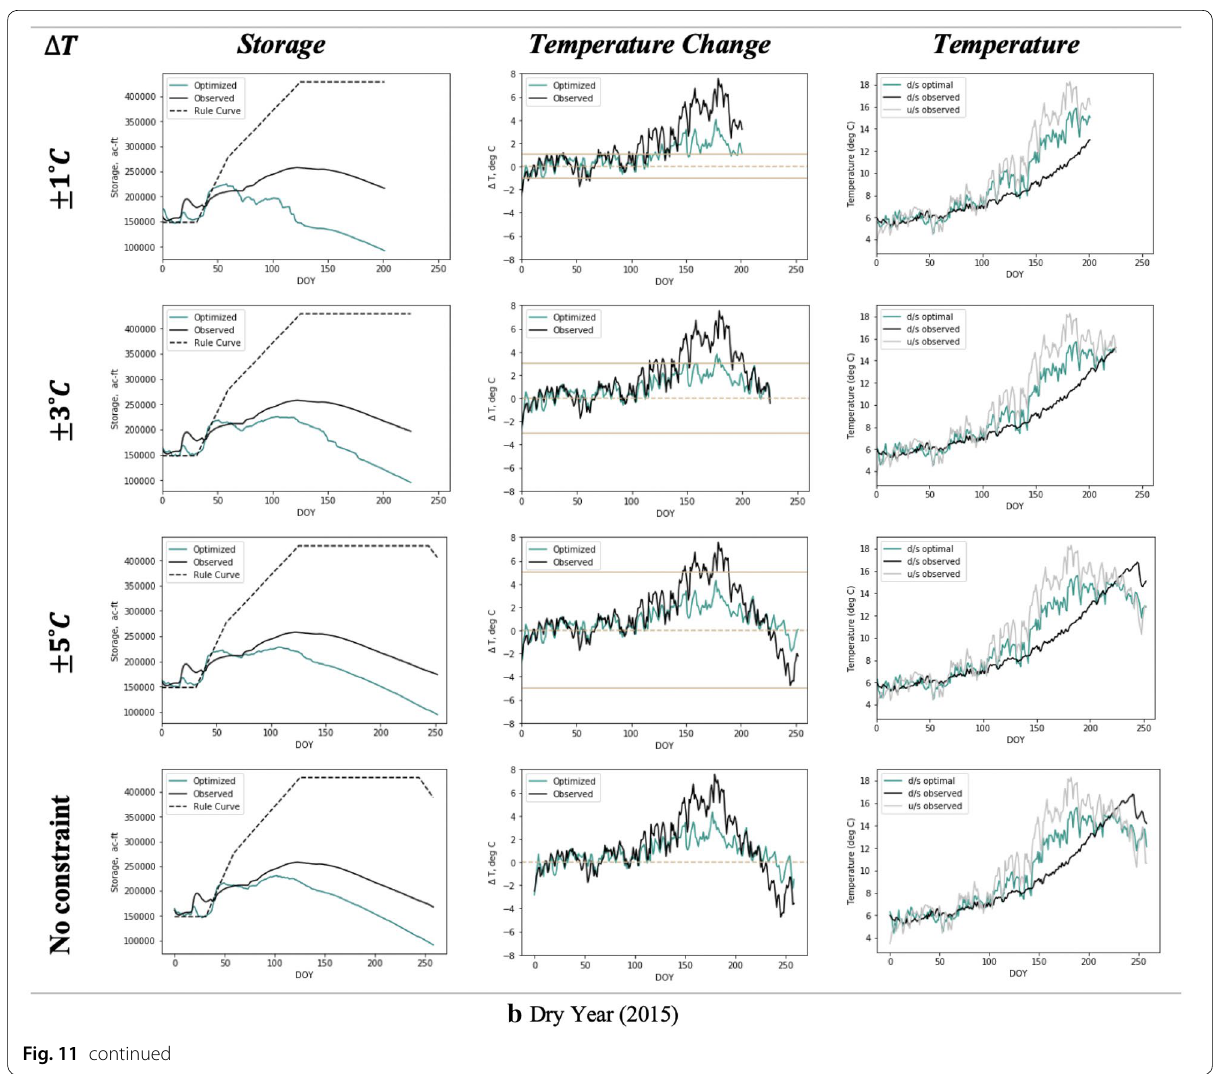
Table 4 Tradeoffs in hydropower generation for a set of constraints of allowable change in temperature ∆ T (°C)